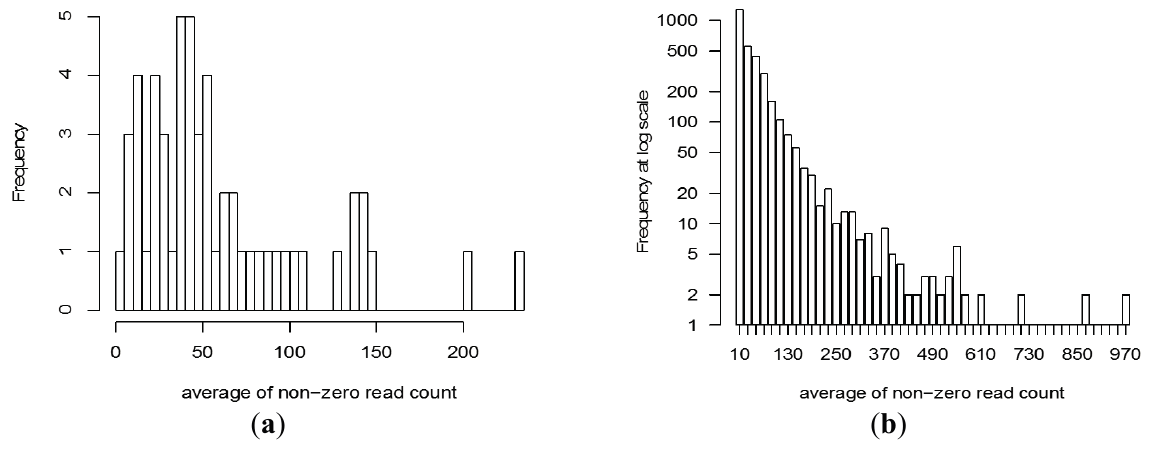
Figure 5. Distribution of non-zero read count less than 10 for each CrERV. The histogram shows the proportion of the 3160 CrERV integration sites in 55 animals that have read counts from one to